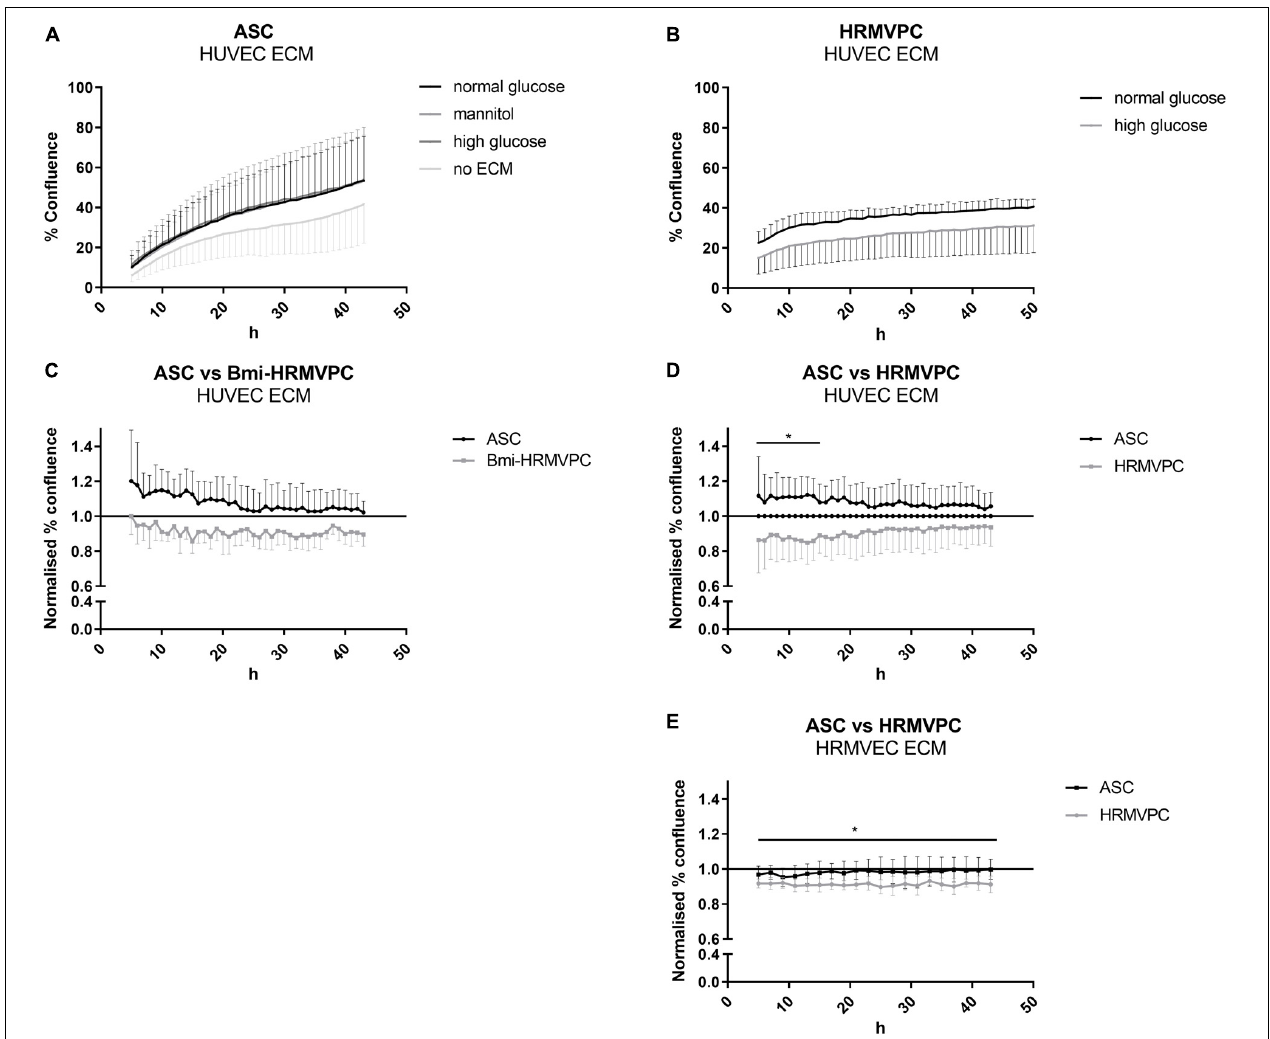
FIGURE 2 | Human retinal microvascular pericytes (HRMVPC) show impaired interaction with high glucose (HG)-conditioned endothelial cells (EC) extracellular matrix (ECM) compared to adipose-derived stromal cells (ASC). The EC, either human umbilical vein endothelial cells (HUVEC) or human retinal microvascular endothelial cells (HRMVEC), were grown until confluence in normal glucose (NG), HG, or mannitol-supplemented medium. Then, the EC ECM was prepared as described in section “Materials and Methods”. ASC or HRMVPC were seeded on top, and the increase in confluence was monitored using live cell imaging over 48 h. (A) Confluence of ASC seeded on HUVEC ECM conditioned by NG, HG, or mannitol ( n = 4 biological replicates; non-significant, two-way RM-ANOVA with Dunnett’s post hoc test). (B) Confluence of HRMVPC seeded on HG-conditioned HRMVEC ECM compared to NG-conditioned ECM ( n = 5 independent experiments